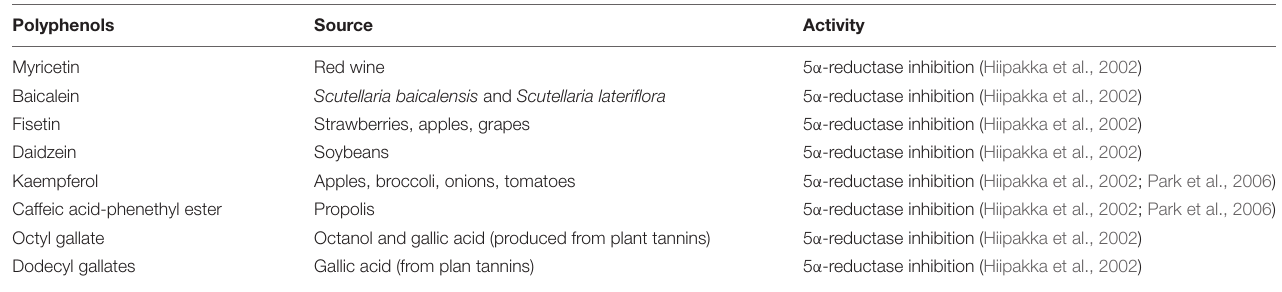
TABLE 2 | Dietary polyphenols identified with BPH suppressing